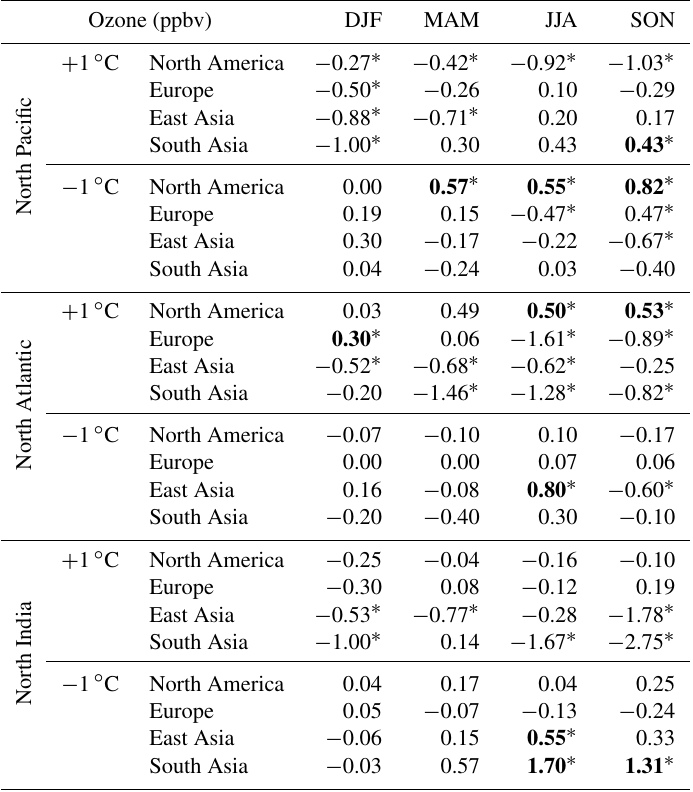
Table 1. Seasonally (i.e., DJF: December, January, and February; MAM: March, April, and May; JJA: June, July, and August; and SON: September, October, and November) and regionally averaged (only land grid boxes are included) changes in surface O 3 concentrations (ppbv) for basin-scale SST perturbation cases relative to the control simulation. Positive changes that are significant at the 0.05 level evaluated using the Student’s t test are marked in